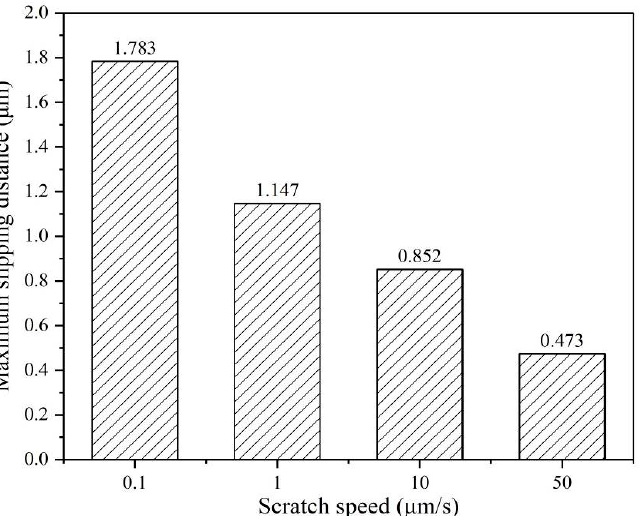
Figure 7. The maximum slipping distance of indenter perpendicular to the scratch direction at different speeds.